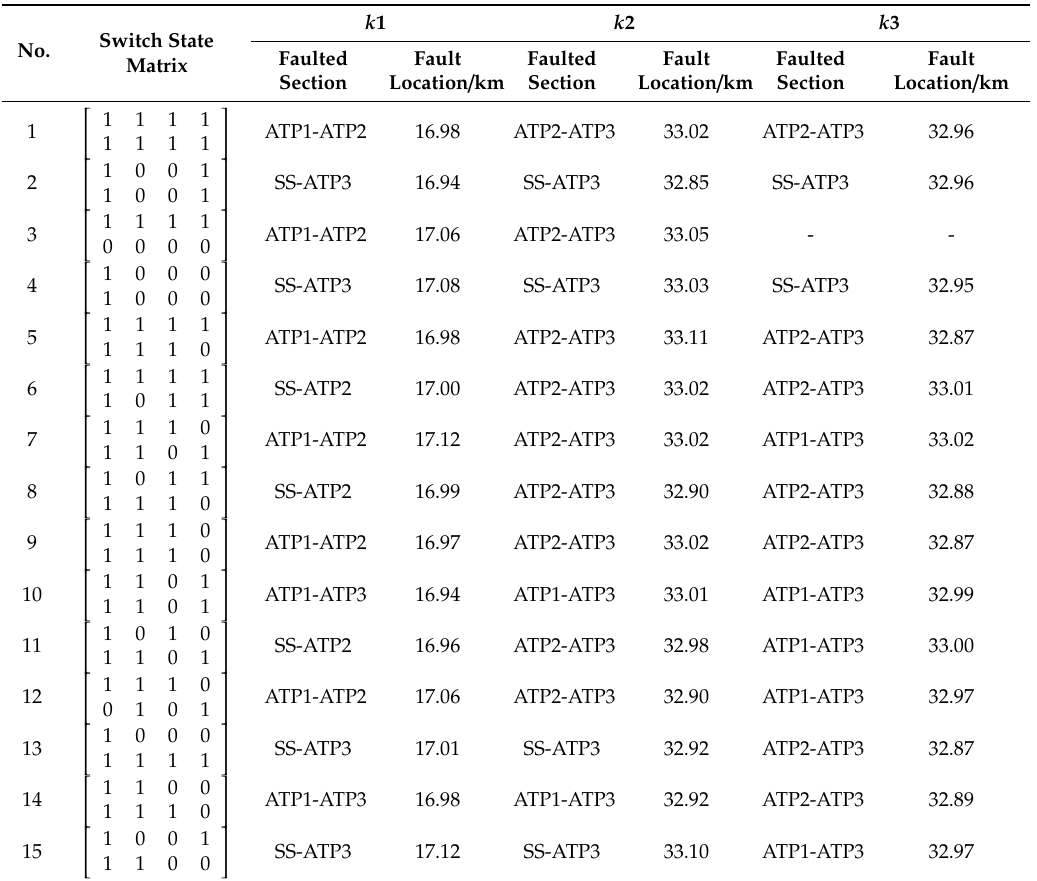
Table 3. Results for typical feeding